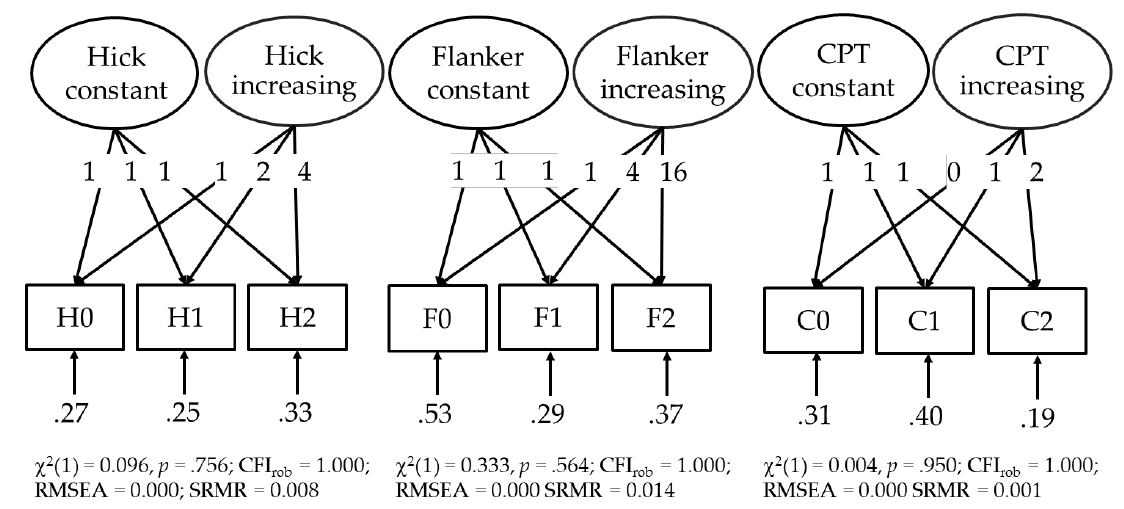
Figure 3. Fixed-links models for the Hick task, the flanker task, and the continuous performance test (CPT). Unstandardized factor loadings are presented as well as model fit by the χ 2 test, the robust comparative fit index (CFI rob ), the root mean squared error of approximation (RMSEA), and the standardized root mean square residual (SRMR).